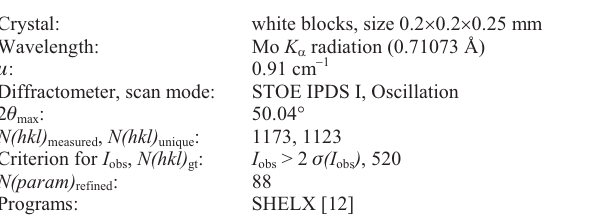
Table 1. Data collection and handling.